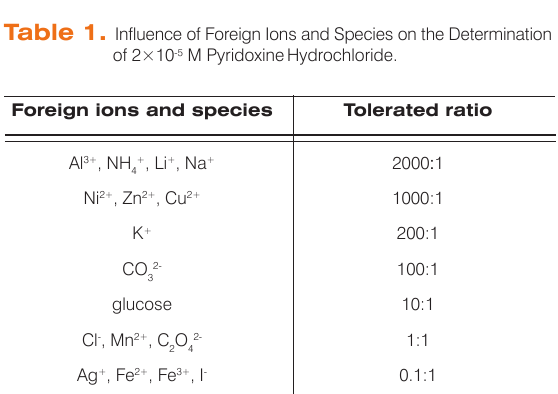
) = 3.595×10 -3 M. (b) [NaBrO 4 2